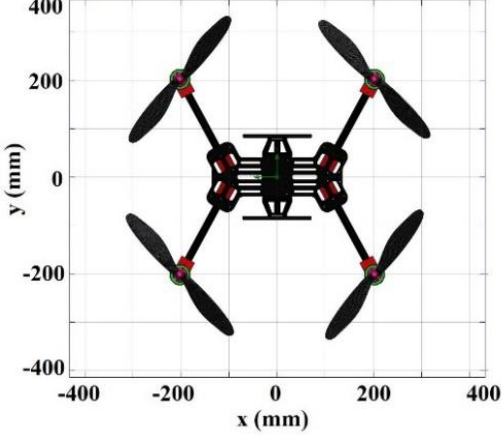
Figure 2. The sni ff er quadcopter Figure 2. The sniffer quadcopter design.